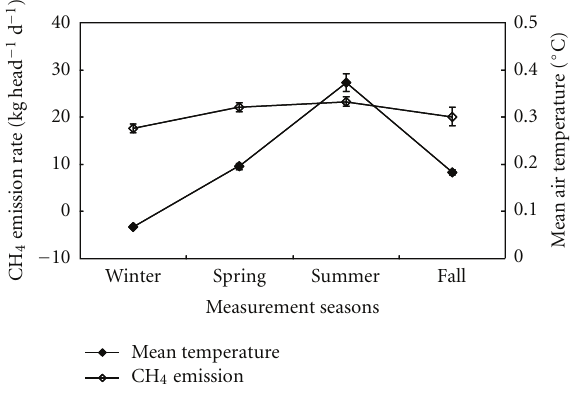
Figure 4: Daily methane emission rates and average temperature during winter, spring, summer, and fall